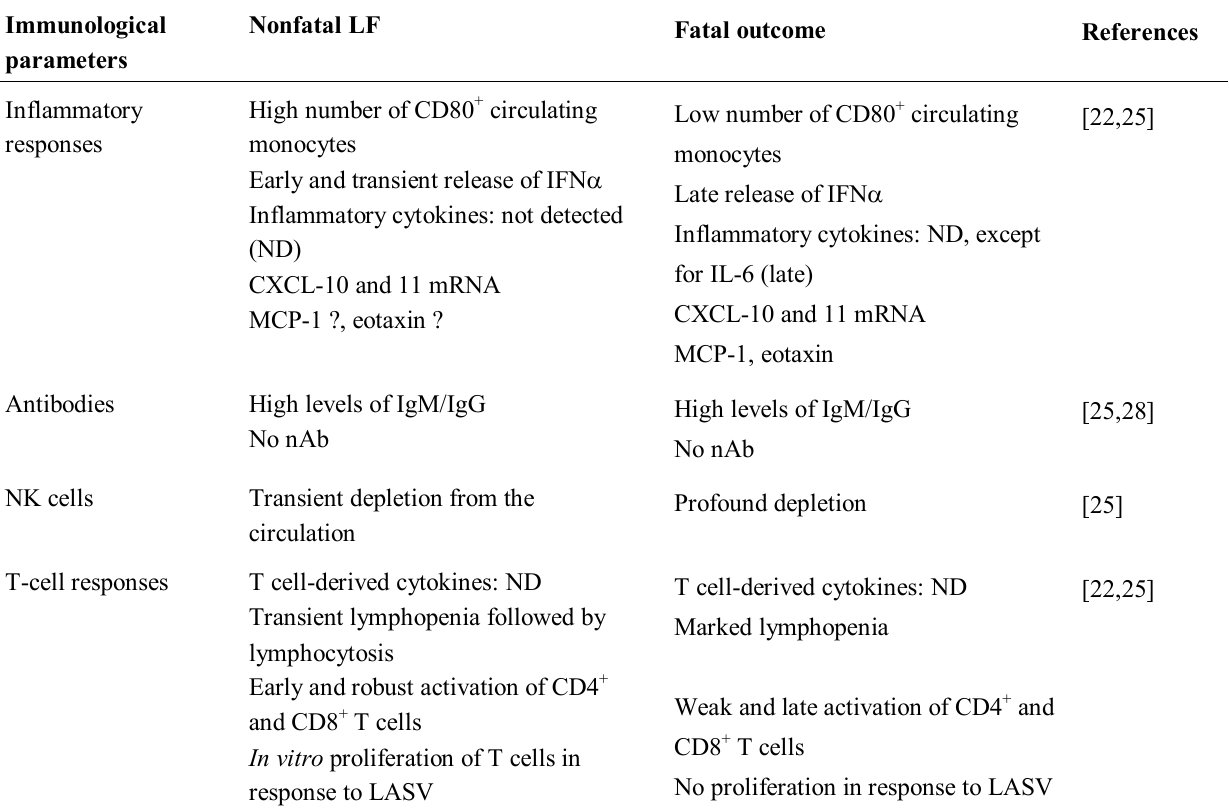
Table 1. Immunological features of Lassa fever in nonhuman primates as a function of outcome